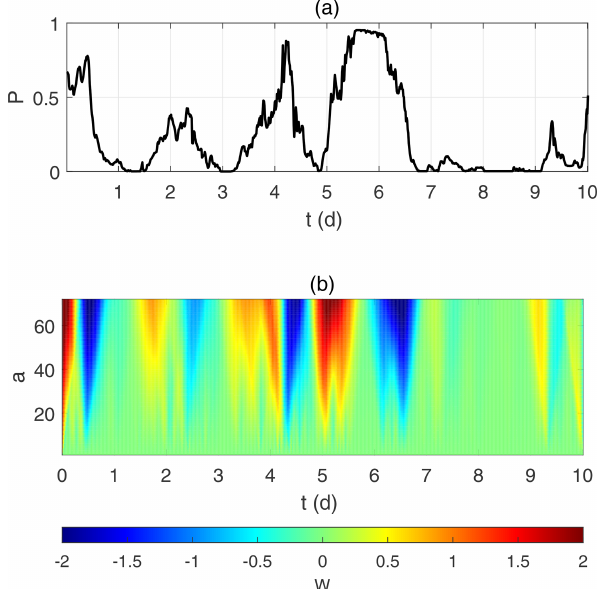
Figure 1. (a) Aggregated Belgian offshore wind power output over the period 27 January to 7 February 2015. (b) Continuous wavelet transform of the wind power data using the Haar mother